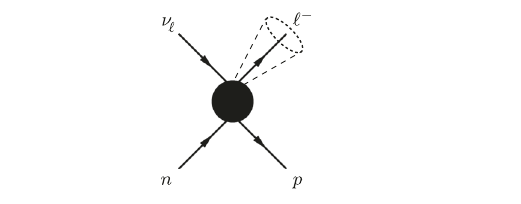
Fig.1|Schematicrepresentationofcharged-currentelasticevent. Photonsthat are within an angle Δ θ of the charged lepton, or that have energy below Δ E , are included in the cross